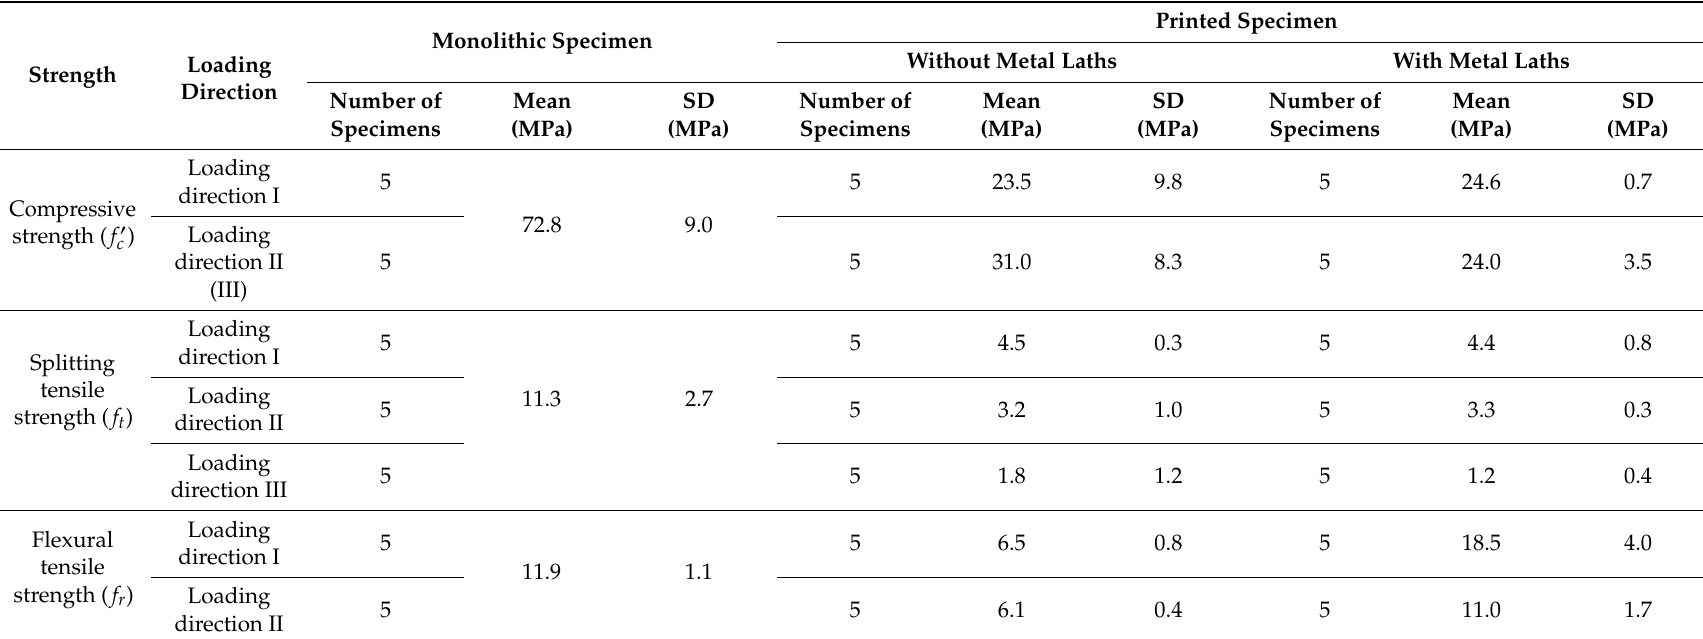
Table 3. Test results for the mechanical